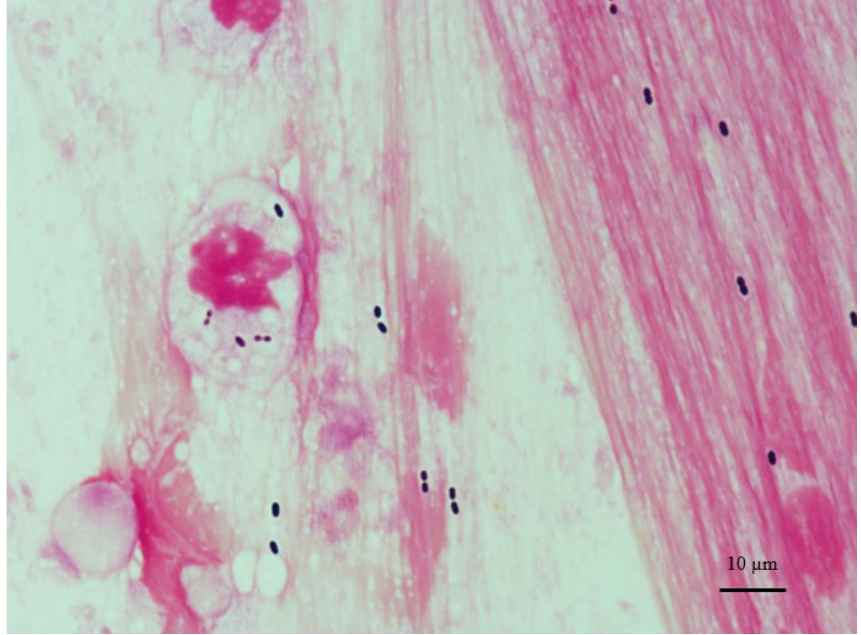
monia. The picture was provided by Tomoko Ohno and Hiroyuki Suematsu, who are microbiologists at Aichi Medical University hospital (Original magnification ×